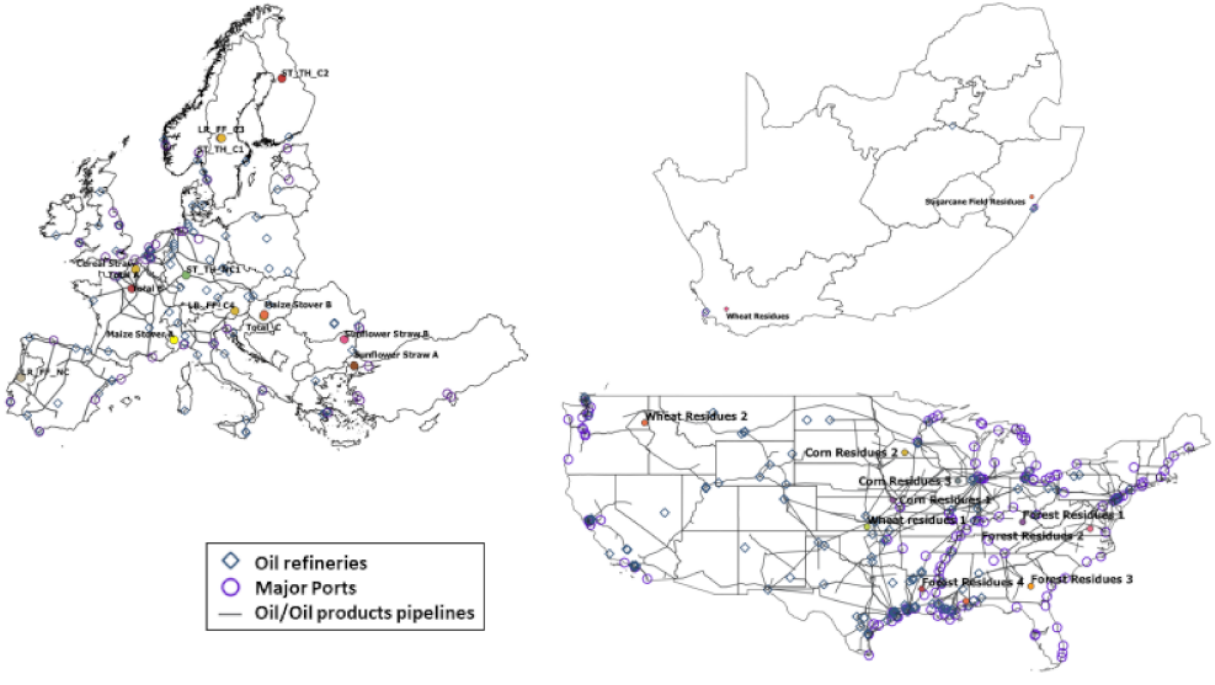
Figure 14. Hotspots and infrastructure in Europe ( left ), South Africa ( top right ) and US ( bottom right